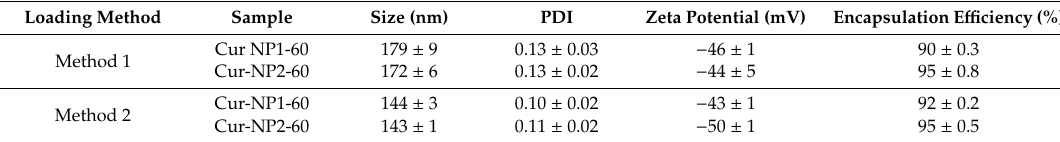
Table 2. Characterizations of curcumin-loaded nanoparticles.